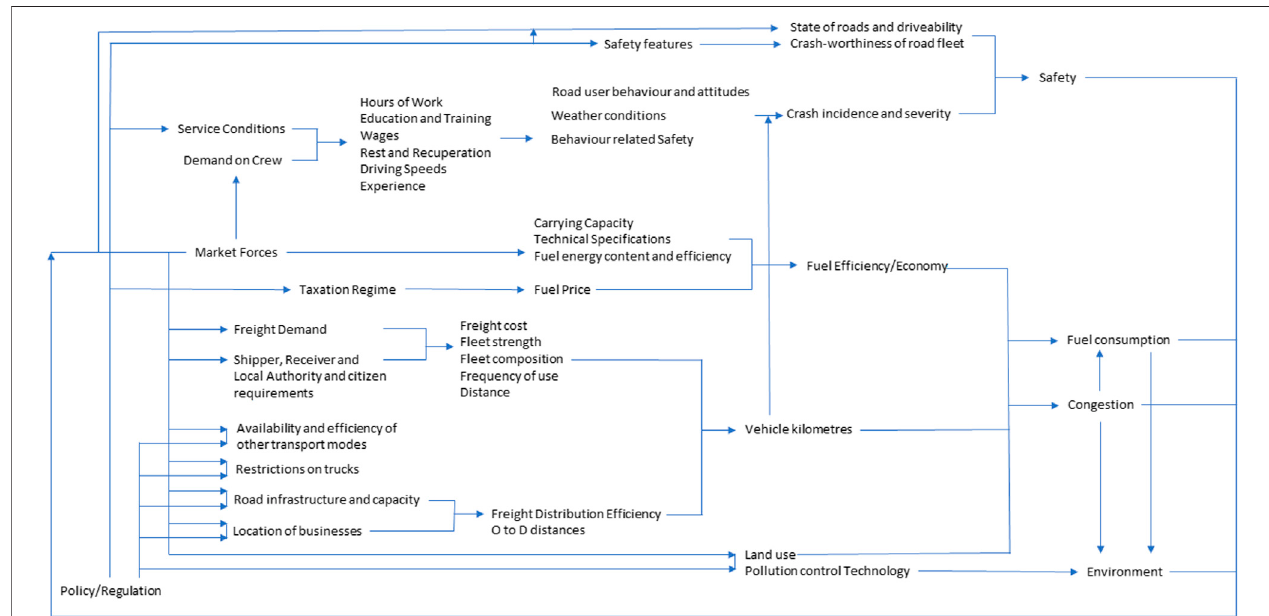
FIGURE 4 | Key elements of a sustainable freight transport system (based on Richardson,